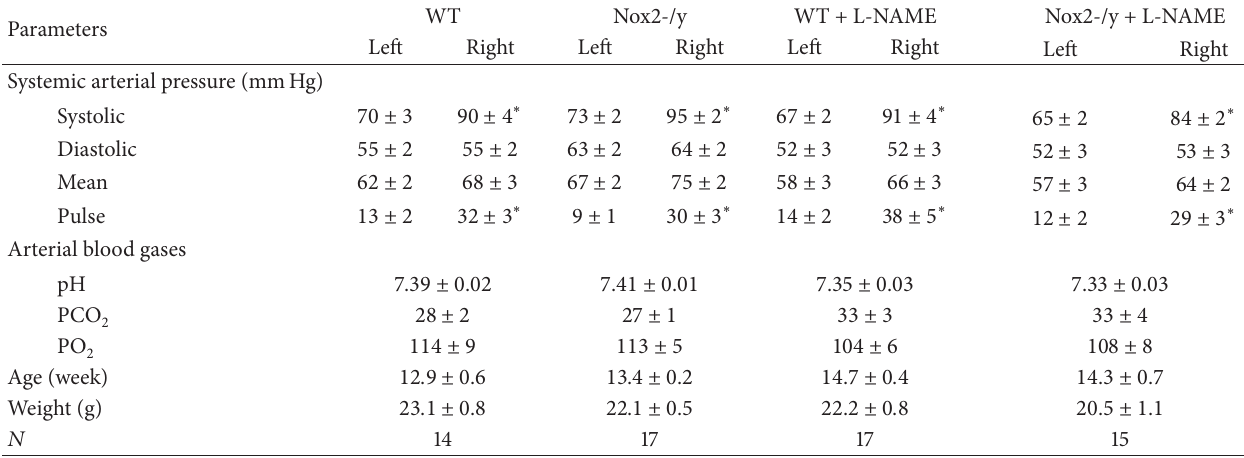
Table 1: Summary of blood pressures (measured by carotid catheters in anesthetized mice) and arterial blood gases in WT and Nox2-/y mice. Parameters